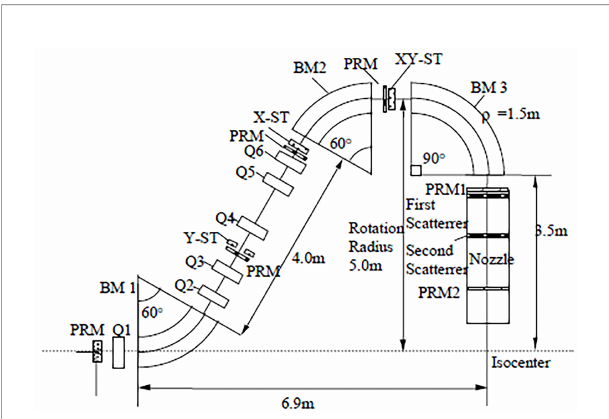
FIGURE 3 | Pavlovic (30) layout of magnets in an ion therapy gantry – after (5). In this example two bending dipoles (BM 1 and BM 2) offset the beam 5 m from the isocenter and dipole BM 3 bends the beam back towards the isocenter and the patient platform. In other systems BM 1 and BM 2 would have other but equal bend angles [e.g. 45° (19)], and still others may employ only two bending magnets (e.g. BM 1 with 45°or 60° and BM 3 with 135°or150°) to achieve the same result (31, 32).